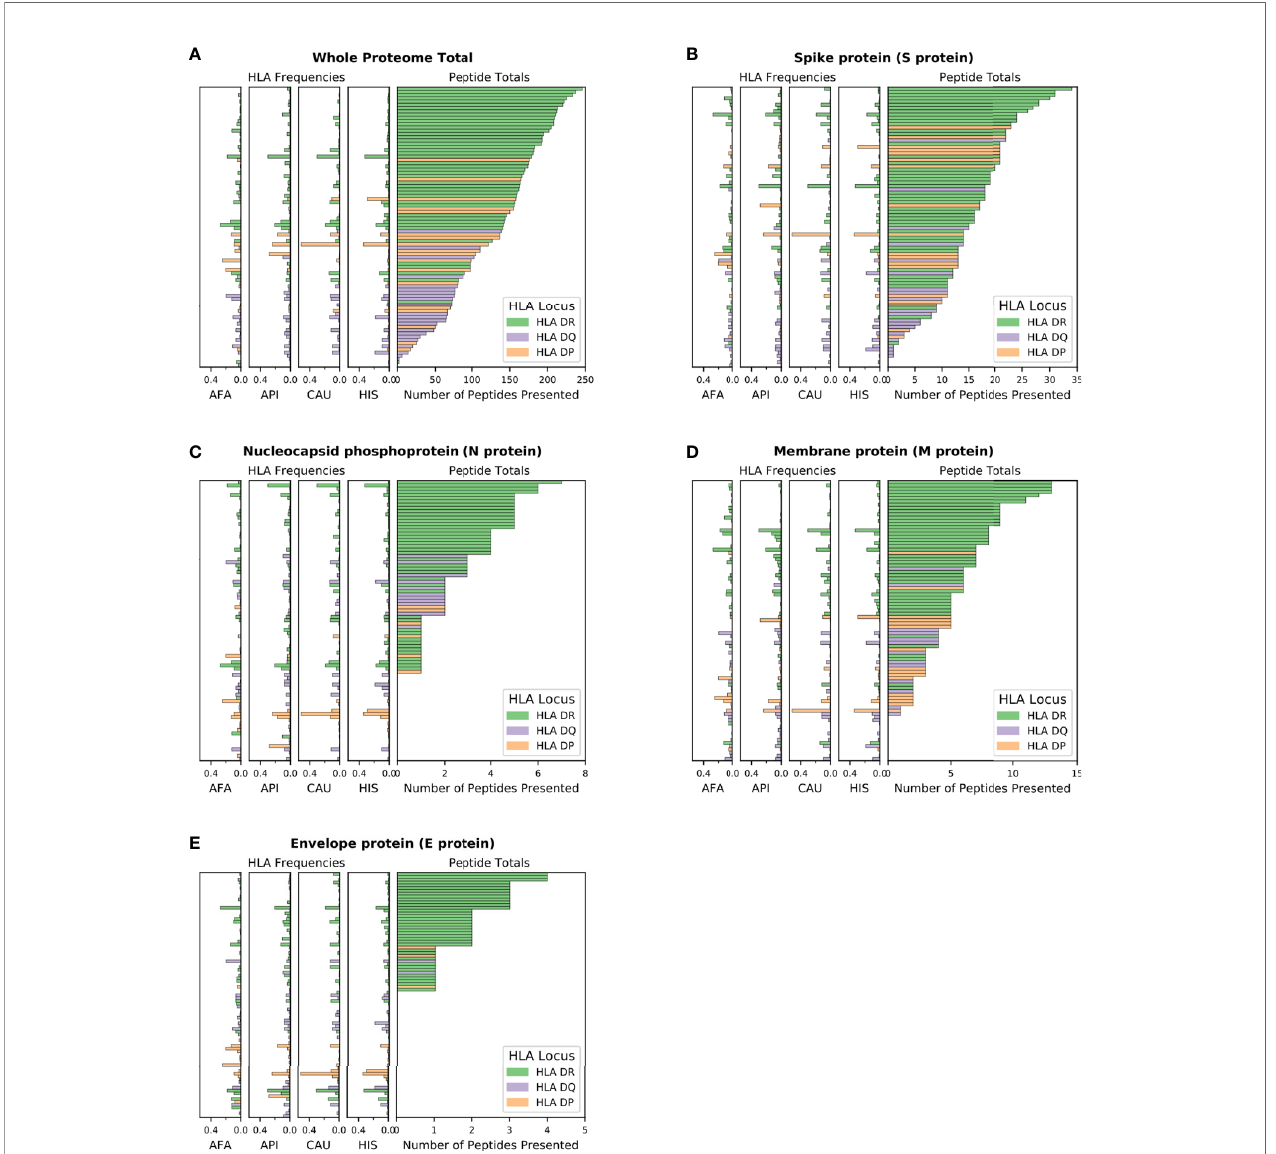
FIGURE 1 | SARS-CoV-2 viral proteome presentation at the molecular HLA class II level. The number of viral peptides presented by individual HLA is shown for (A) the entire SARS-CoV-2 proteome; (B) . Spike protein (S protein); (C) Nucleocapsid protein (N protein); (D) Membrane protein (M protein); and (E) Envelope protein (E protein). The HLA frequency in four broad ethnic populations is shown (AFA, African Americans; API, Asian and Paci fi c Islanders; CAU, Caucasians; HIS, Hispanics). Bars are coloured according to HLA locus, as shown. HLA were included in the fi gure if they had a frequency of ≥ 1% in any haplotype distribution from the four broad population